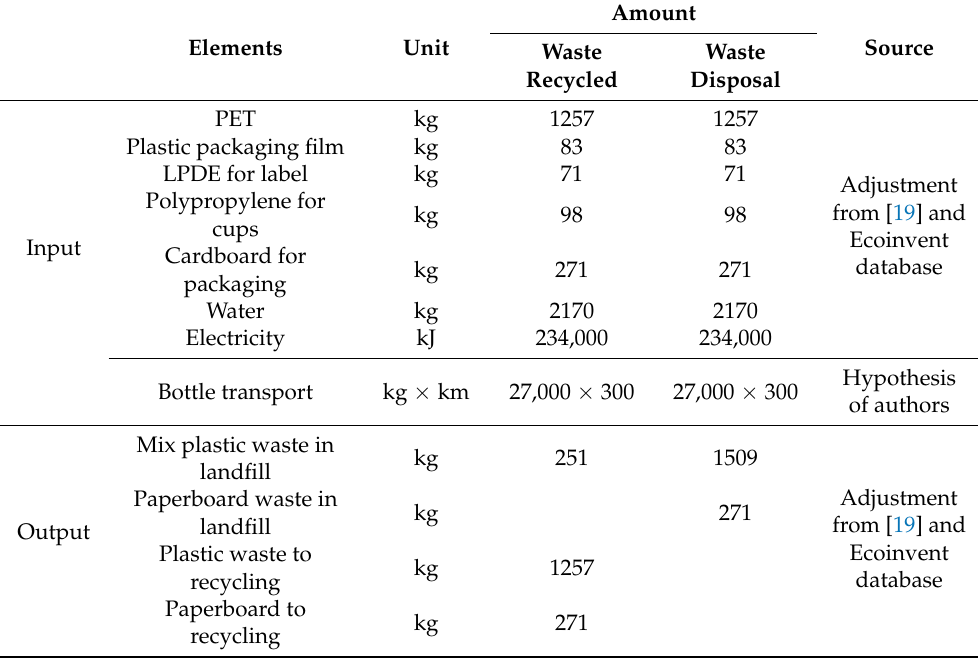
Table 2. Summary inventory data of bottled water. All data are referred to the functional unit: 26 m 3 of water. Elements Unit